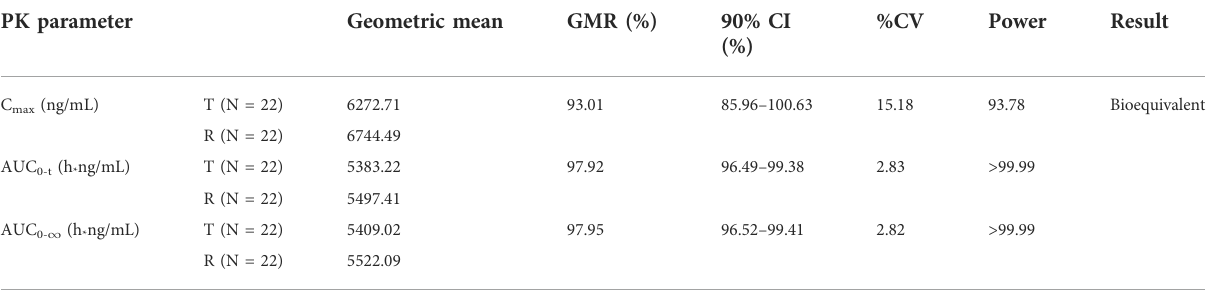
TABLE 3 Results of the bioequivalence determination of Cefaclor granule and Cefaclor suspension in fasting sequence.